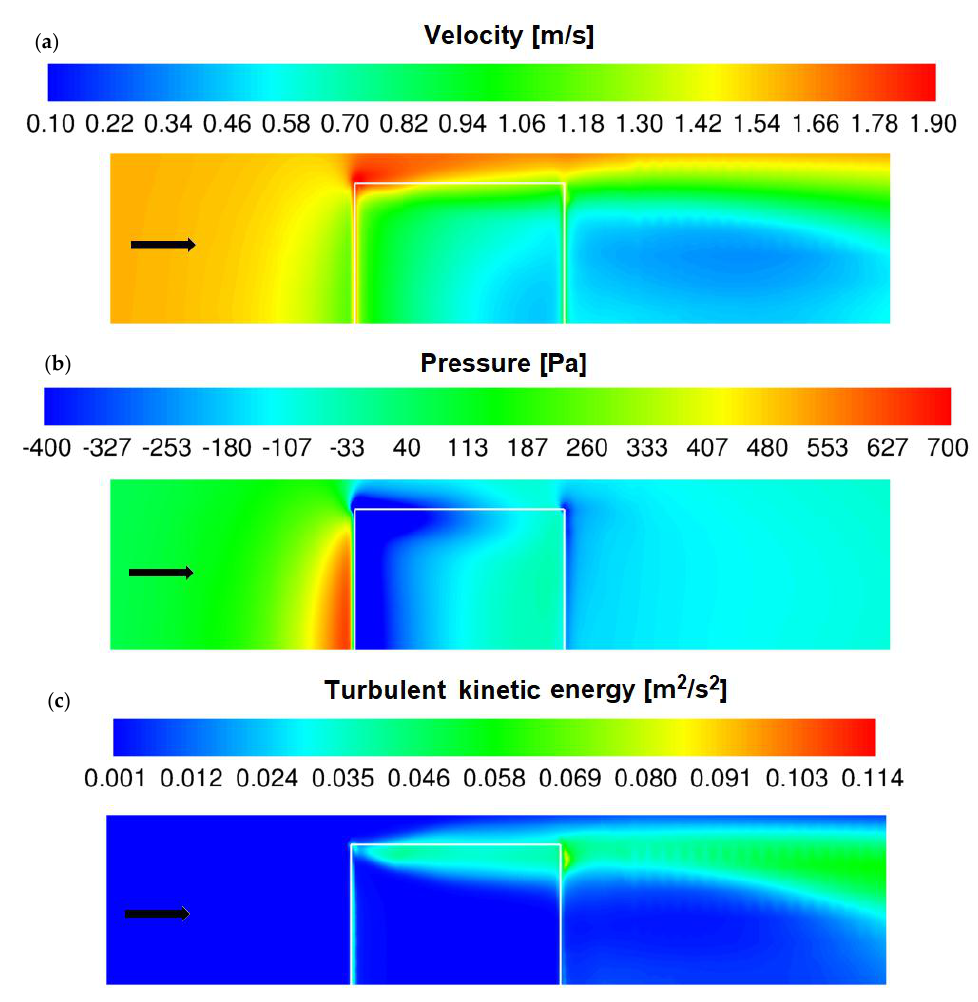
Figure 16. Averaged fluid variables in the vertical middle plane ( z = 0). ( a ) Velocity, ( b ) pressure, ( c ) turbulent kinetic energy. The white line indicates the projection of Σ surface.